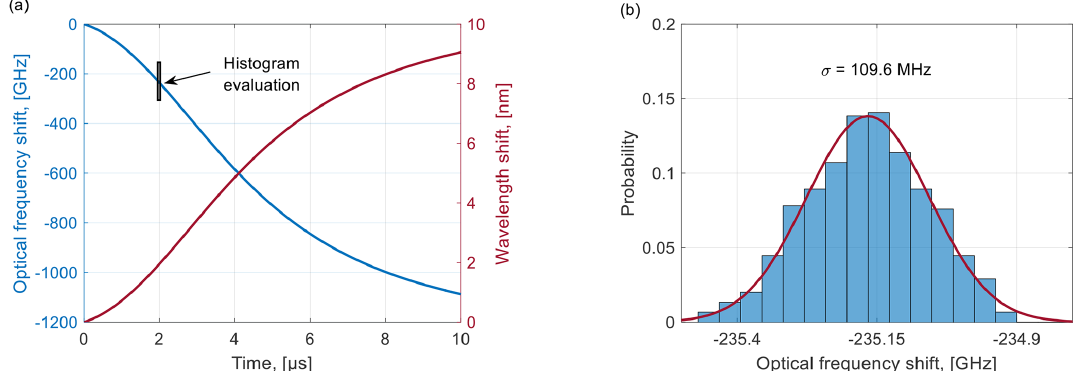
Figure 10. (a) Overlapping of instantaneous optical frequency shifts over 450 consecutive pulses for VCSEL VL-1577 by the pump current pulse width of 12µs and the repetition rate of 50Hz ( i B = 1, i P = 18mA) and (b) histogram evaluated at a time of 2µs and fitted with a normal